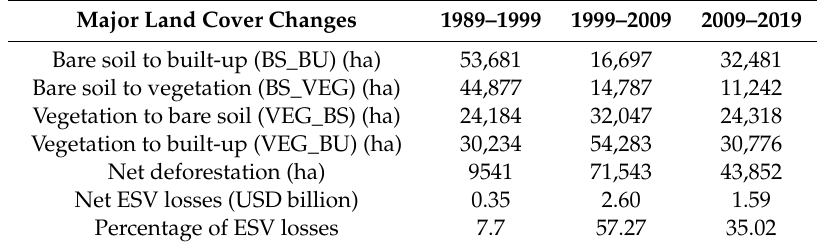
Table 6. LULC transitions and ecosystem service value changes over the 30-year period. Major Land Cover